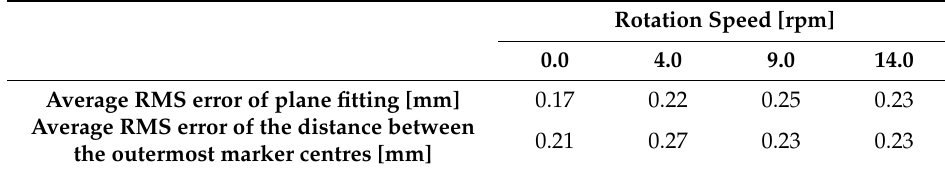
Figure 13. Examples of RMS errors obtained by plane fitting for a single DMH, for stable and rotating calibration artefact: ( a ) 0.0 rpm; ( b ) 4.0 rpm; ( c ) 9.0 rpm; ( d ) 14.0 rpm. In each panel, the outermost left and right images correspond to when the calibration artefact was oriented diagonally in the measurement volume. The middle image was taken when the calibration artefact was oriented perpendicular to the DMH. A portion of the upper left corner of the calibration artefact is missing from some of the images because part of the artefact was outside the calibrated volume. Table 3. Root mean square (RMS) errors for the analysed dynamic scenarios.